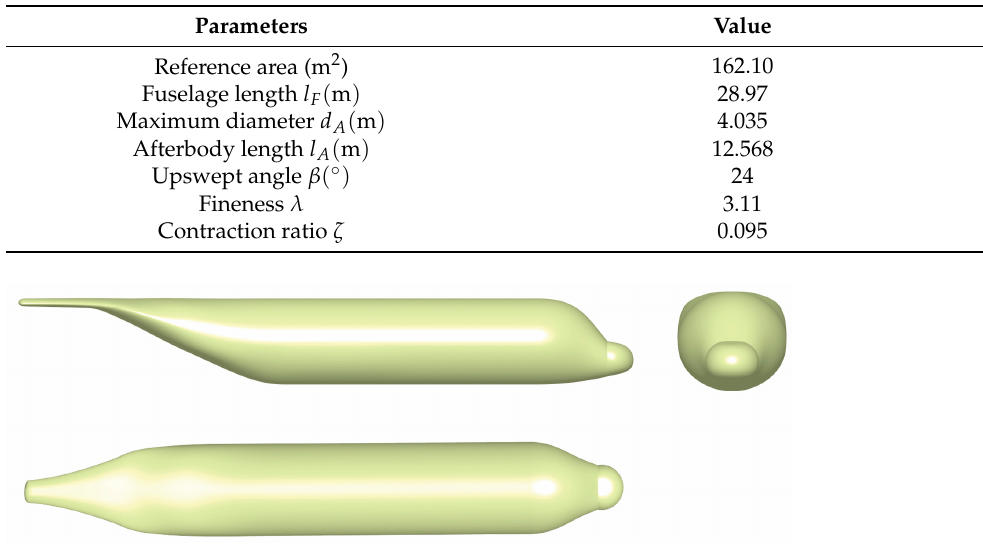
Table 1. Parameters of the military transport aircraft model.